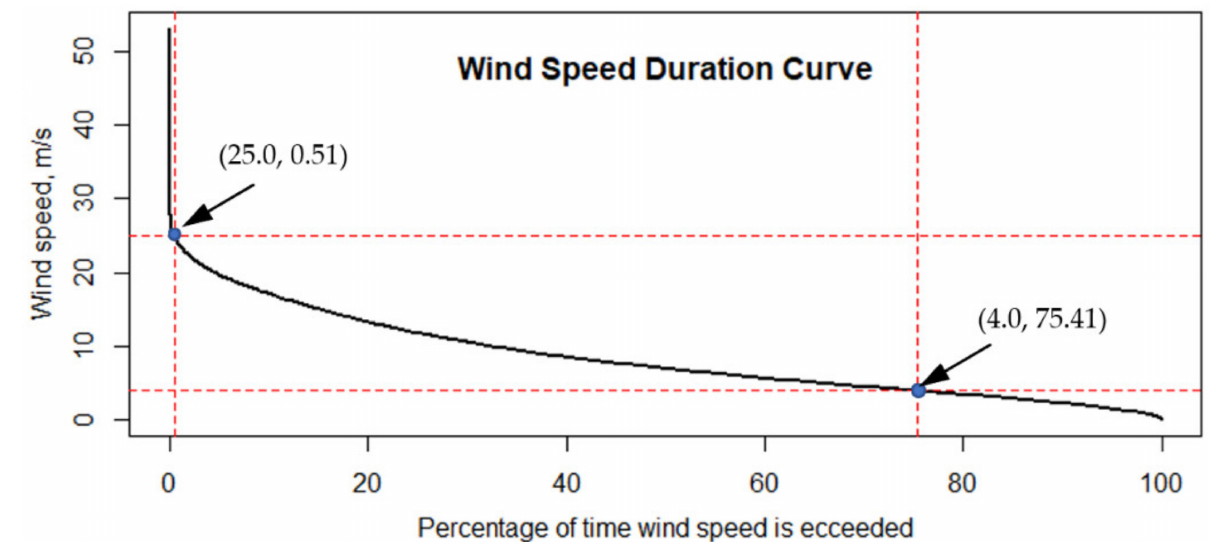
Figure 2. BSMI wind speed (at 100 m elevation) duration